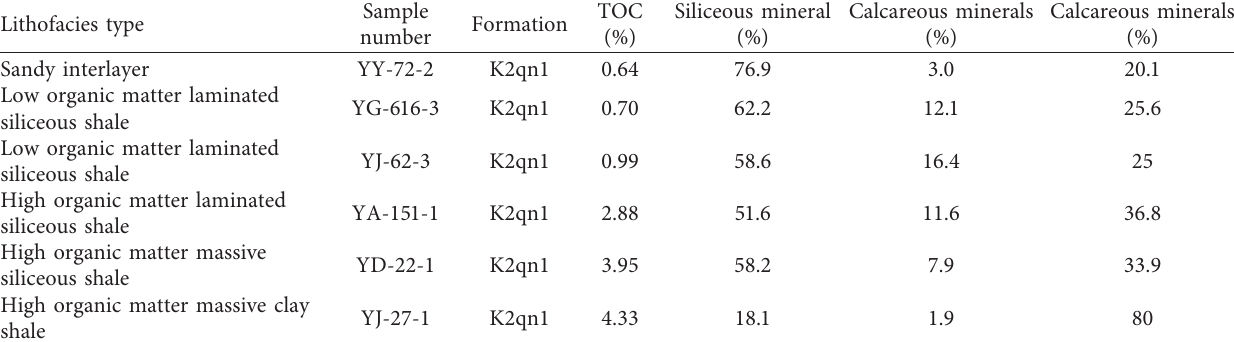
Table 1: Basic geochemical parameters and mineral composition information of